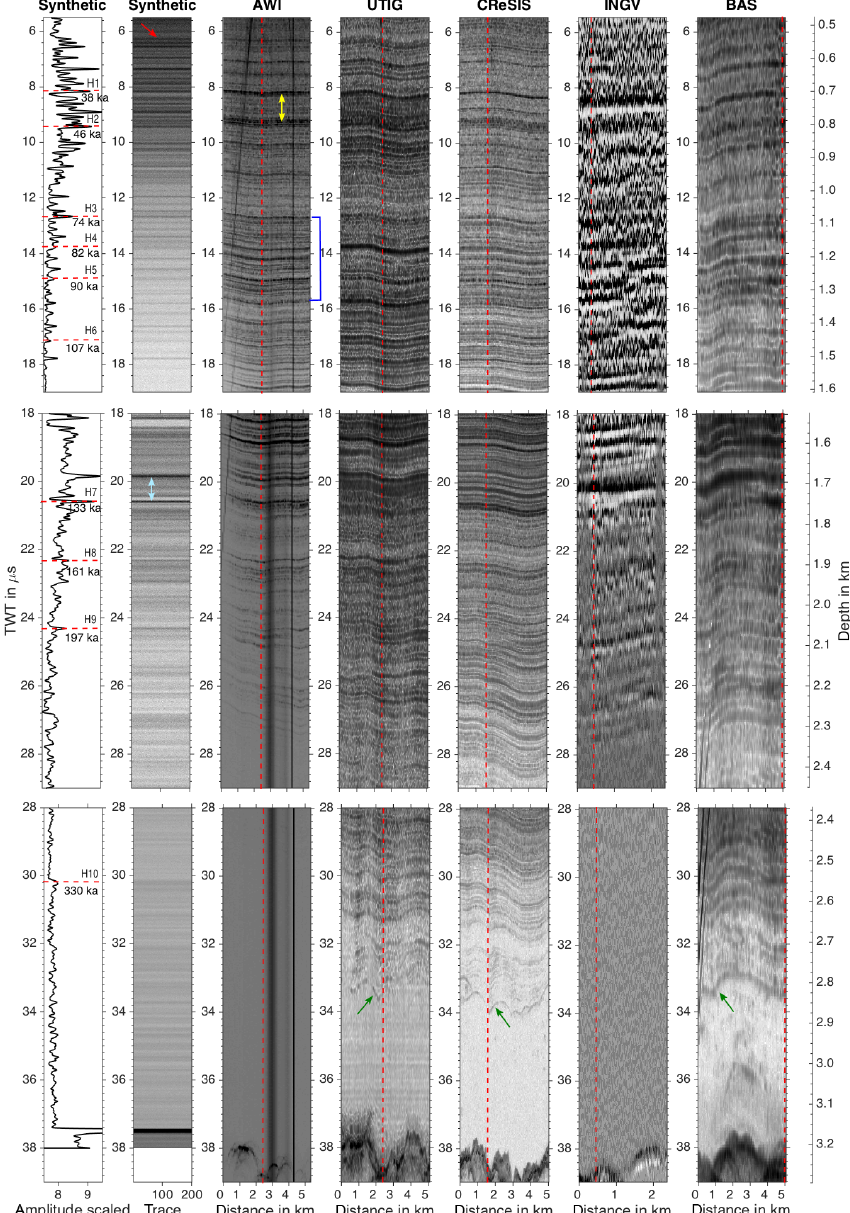
Figure 3. Z-scopes for synthetic and RES data sets of the five radar systems. The surface reflections are shifted to time zero as shown in Fig. 2 and the vertical red lines mark the positions of the traces of Fig. 2. The length of the RES profiles is indicated on the horizontal axes. For the depth axis we convert TWT to depth with a wave velocity of c = 168 . 5mµs − 1 and a firn correction of 10m. For the bottom UTIG and CReSIS panels a 2-D-focused processing is applied. The colored arrows and lines mark distinct reflector patterns, described in detail in Sect.